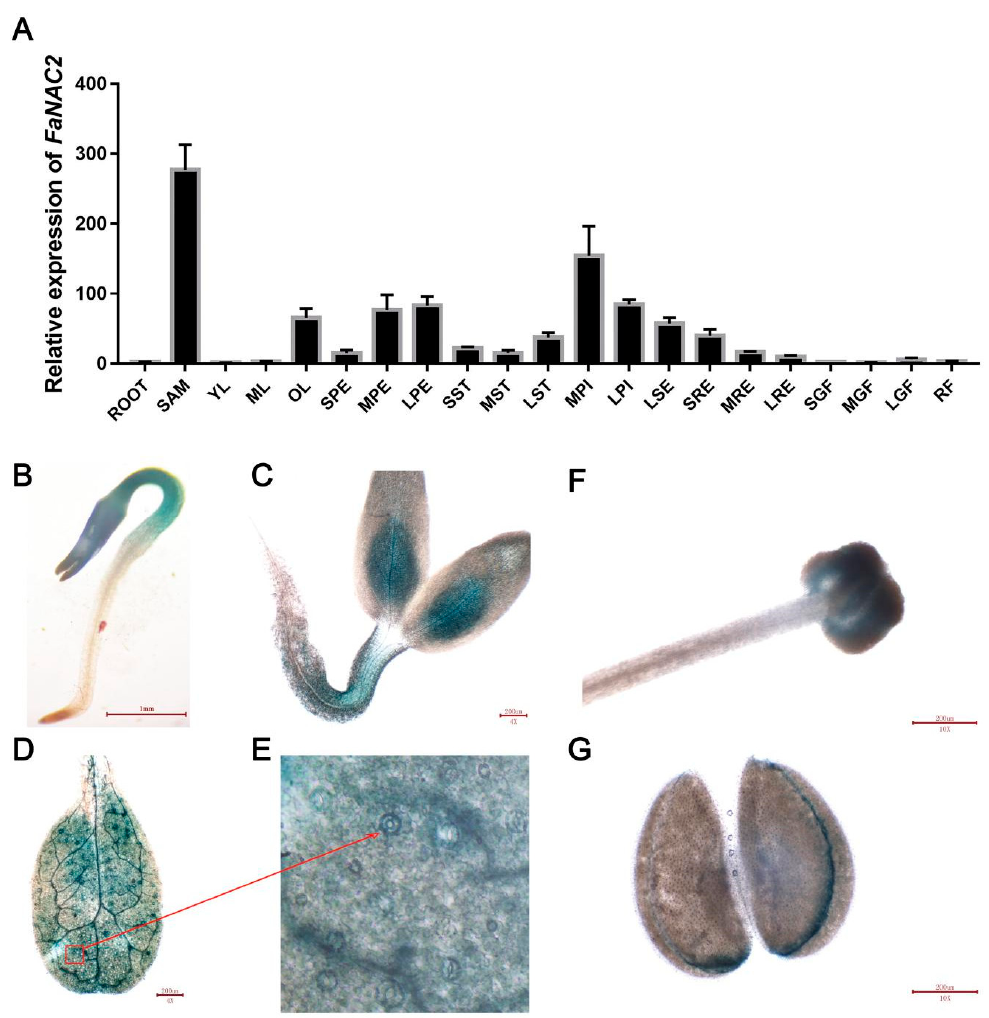
Figure 2. Expression pattern of FaNAC2. ( A ) qRT-PCR analysis of FaNAC2 in different tissues of strawberry. ROOT: roots; SAM: shoot apical meristem; YL: young leaves (the second folded leaf); ML: mature leaves (the third or fourth fully expanded leaf); OL: old leaves (below the seventh leaf); SPE: petals from small flower buds (length <0.5 cm); MPE: petals from middle flower buds (length 0.5–0.8 cm); LPE: petals from large opened flower; SST: stamen from small flower buds; MST: stamen from middle flower buds; LST: stamen from large opened flower; MPI: pistils from middle flower buds; LPI: pistils from large flower buds; LSE: sepals from large opened flower; SRE: receptacles from small flower buds; MRE: receptacles from middle flower buds; LRE: receptacles from large opened flower; SGF: small green fruits; MGF: middle green fruits; LGF: large green fruits; RF: red fruits. The FaACTIN gene was used as an internal reference to normalize the expression data. Data are presented as averages of three biological repeats. Bars are means (±S.D.) of three independent experiments. ( B , C ) β -glucuronidase (GUS) analysis of 5 DAG (days after germination) Pro FaNAC2 –GUS N. benthamiana (Nicotiana benthamiana) seedlings. ( D , E ) GUS analysis of true leaf of 13 DAG seedling and its enlarged view. The red arrow points to guard cells in (E). ( F , G ) GUS analysis of stigma and anther of 35 DAG Pro FaNAC2 –GUS lines after planting on soil.